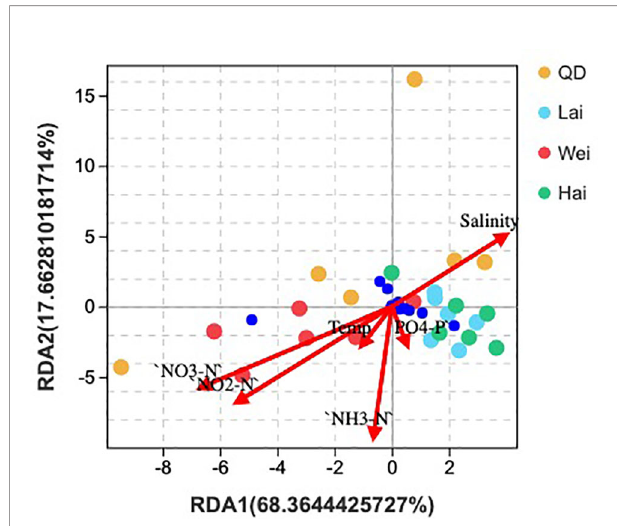
FIGURE 1 | Redundancy analysis on the correlation between relative abundance of microbial community at phylum level and water quality parameters, including phosphate, nitrate, nitrite, ammonia, temperature, and salinity. QD, Qingdao; Lai, Laizhou; Wei, Weihai; Hai,